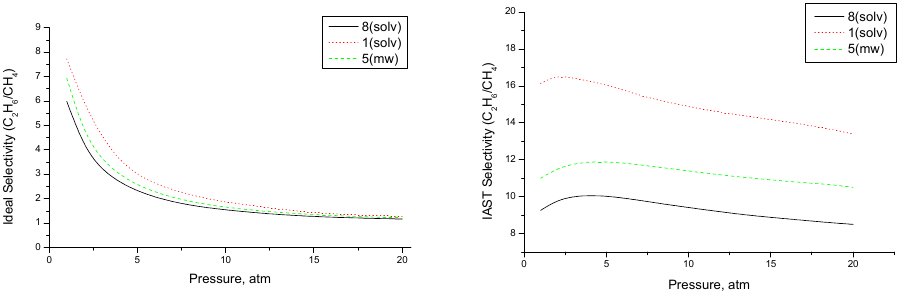
Figure 5. The pressure dependencies of C 2 H 6 /CH 4 ideal and IAST selectivities at 298 K for the 1solv , 5mw and 8solv samples.